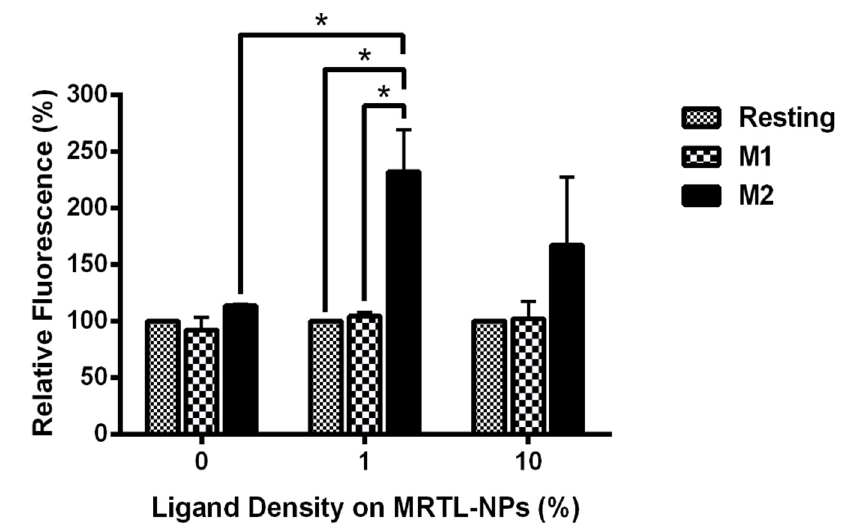
Figure 7. Uptake of FITC-labeled MRTL-NPs with 1% or 10% of the total copolymer termini displaying the mannosylated ligand. Data are the average of two independent rat experiments, each using macrophages pooled from at least two rats. M1 and M2 activated macrophages were incubated with DAPI and either plain (0%) NPs, MRTL 1% -NPs or MRTL 10% -NPs. After incubation, the cells were washed and scraped from the dishes and fixed in 10% formalin in PBS. Cell-associated FITC fluorescence in the fixed cells was then assessed by flow cytometry. The values are expressed relative to that of resting macrophages (i.e., the value of resting macrophages is 100%; *: t test p < 0.05).